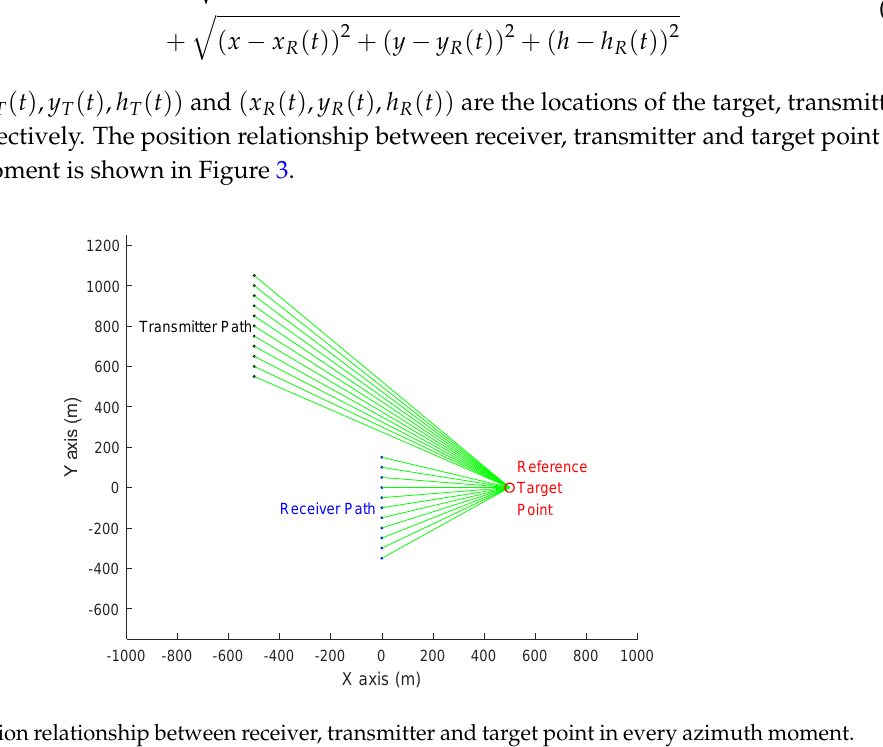
Figure 3. Position relationship between receiver, transmitter and target point in every azimuth